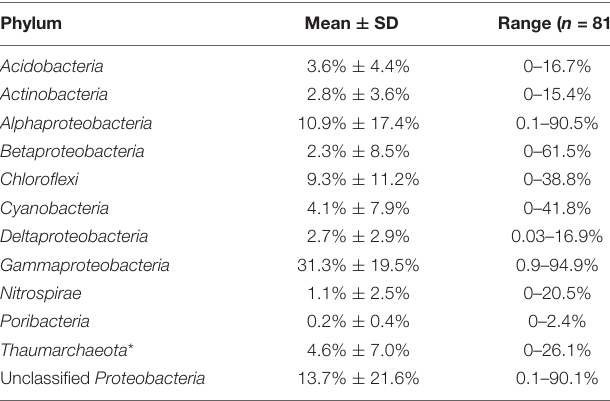
TABLE 4 | Top Phyla present in sponges (data source: Thomas et al., 2016; 81 sponge species). Proteobacteria is separated into classes and unclassified (only classified to